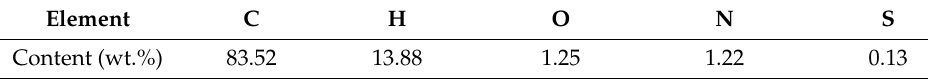
Table 1. Element analysis of WEO.